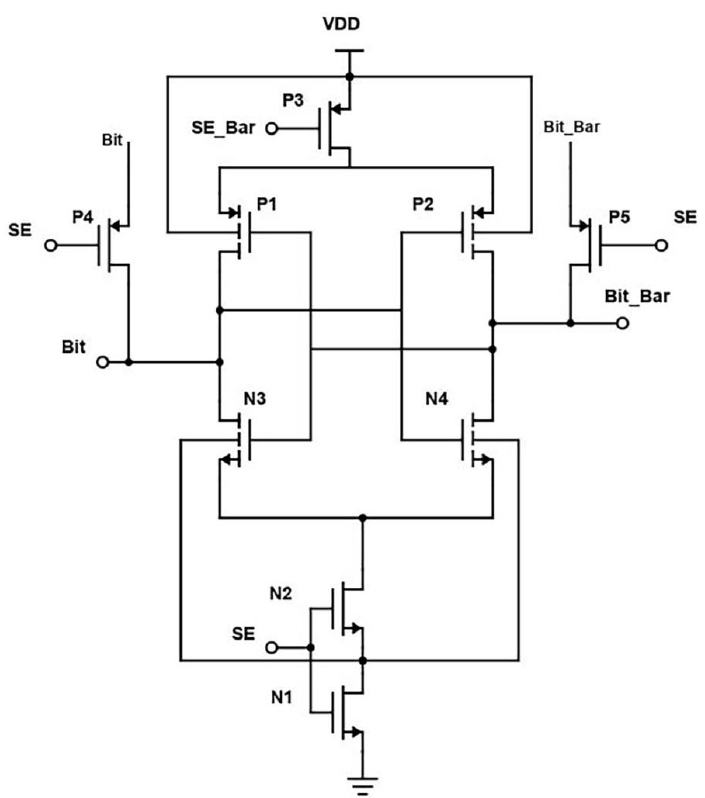
Figure 14. Modified Basic Latch Sense Amplifier with Pass Transistor Schematic.